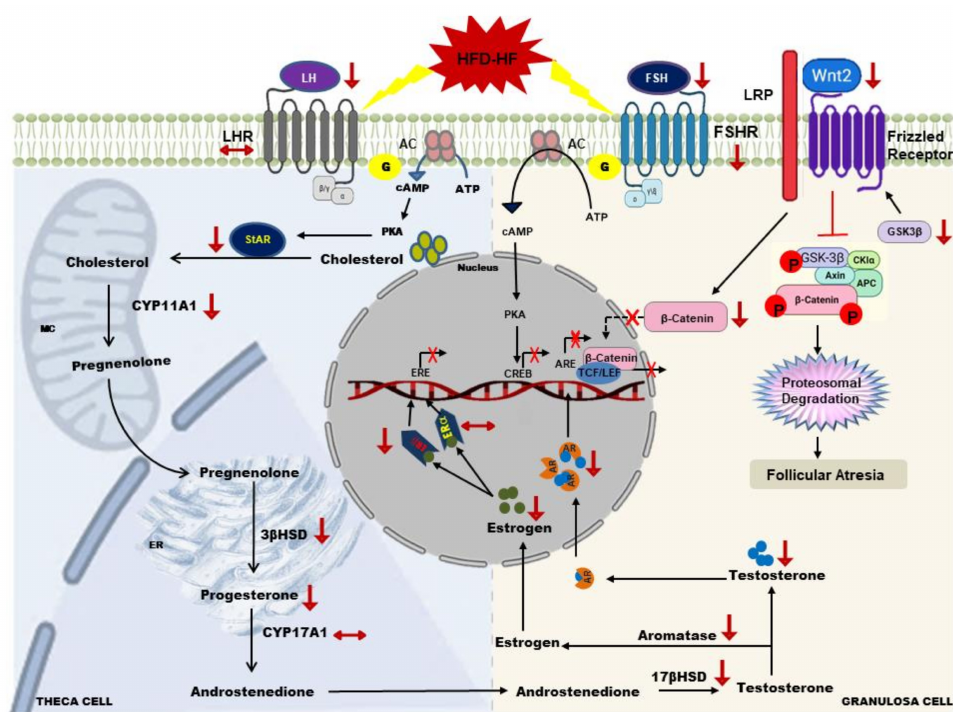
Scheme 2. Effects of HFD-HF diet on the ovarian granulosa and theca